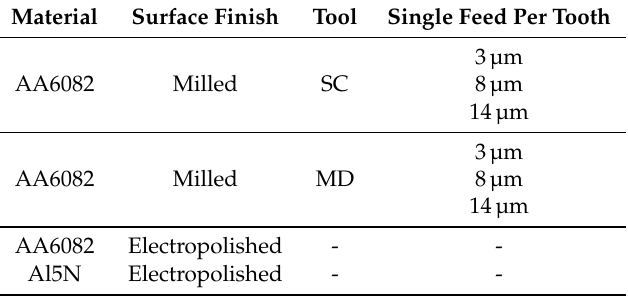
Table 1. Sample overview including the respective raw material, surface treatment, tool used for milling, and feed per tooth.